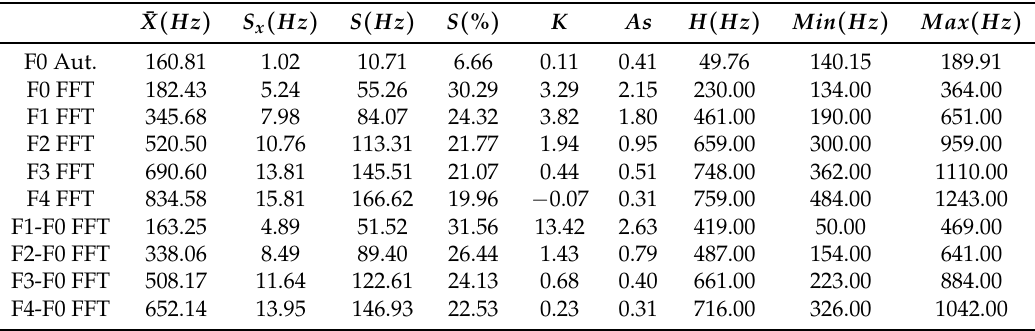
Table A5. Statistical descriptive measures of the frequency data of the standard group of C. capitata .